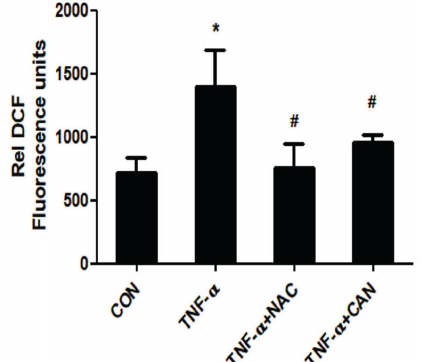
Figure 3 - Candesartan inhibits of ROS generation induced by TNF-α. HKC cells were treated with TNF- α (2ng/ml) along or TNF- α combination with candesartan (10 -5 M) or NAC (1 mM) for 24 hours. Then cell lysates were collected to measure ROS generation by DCF fluorescence assay. n=3. *P<0.05 vs. CON, #P<0.05 vs. TNF- α treatment; CON: control, CAN: